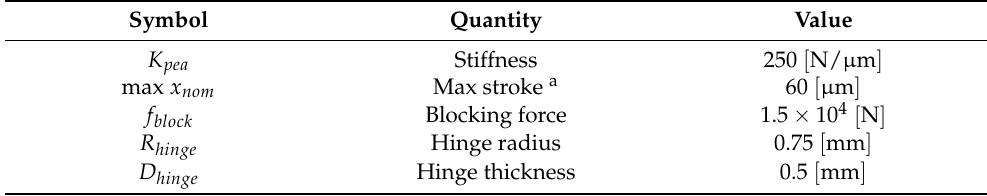
Figure 1. ( a ) Schematic illustration of a single PEA set; ( b ) Design parameters and simplified model of the output port. Table 1. Specifications of the PEAs.